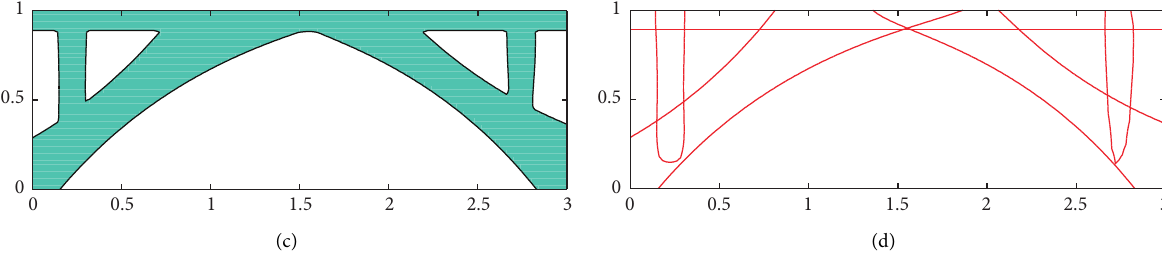
Figure 20: Some intermediate optimization results and the final results of the bridge example with the paper